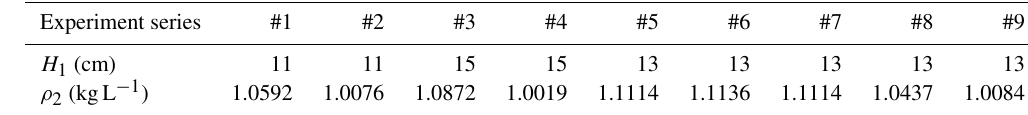
Table 2. Geometrical and physical characteristics of the experiment series.